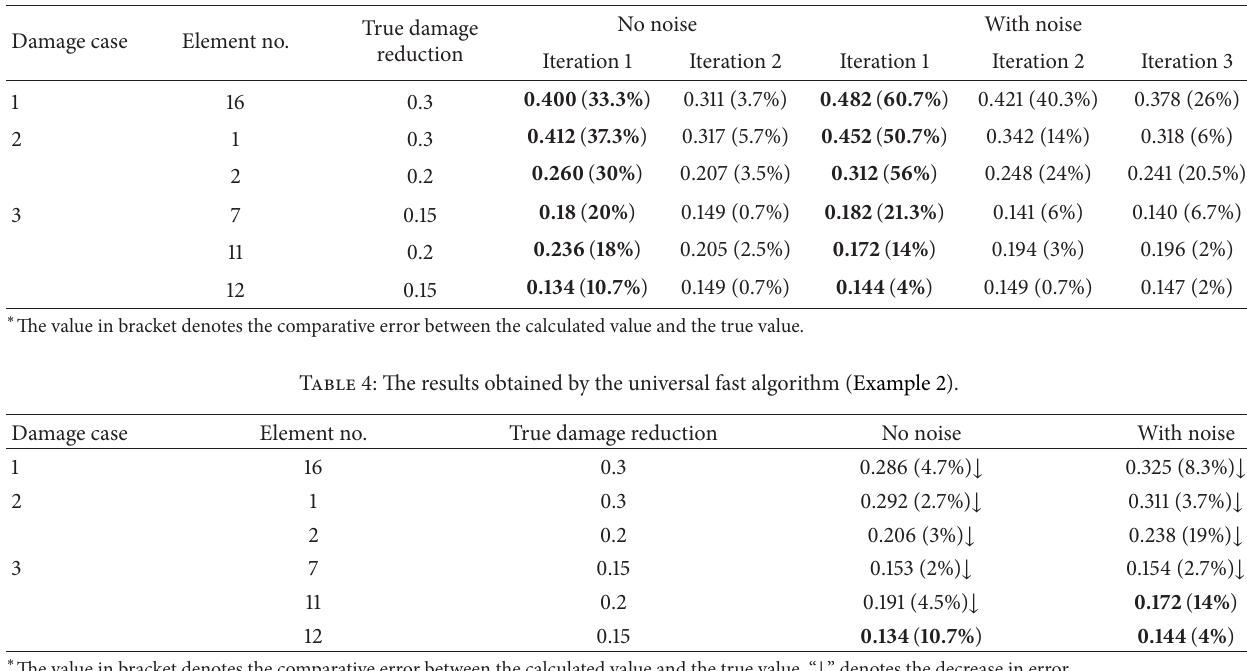
Table 5: Comparisons of the estimated damage parameters by the original generalized flexibility sensitivity method and the fast algorithm (Example 3).